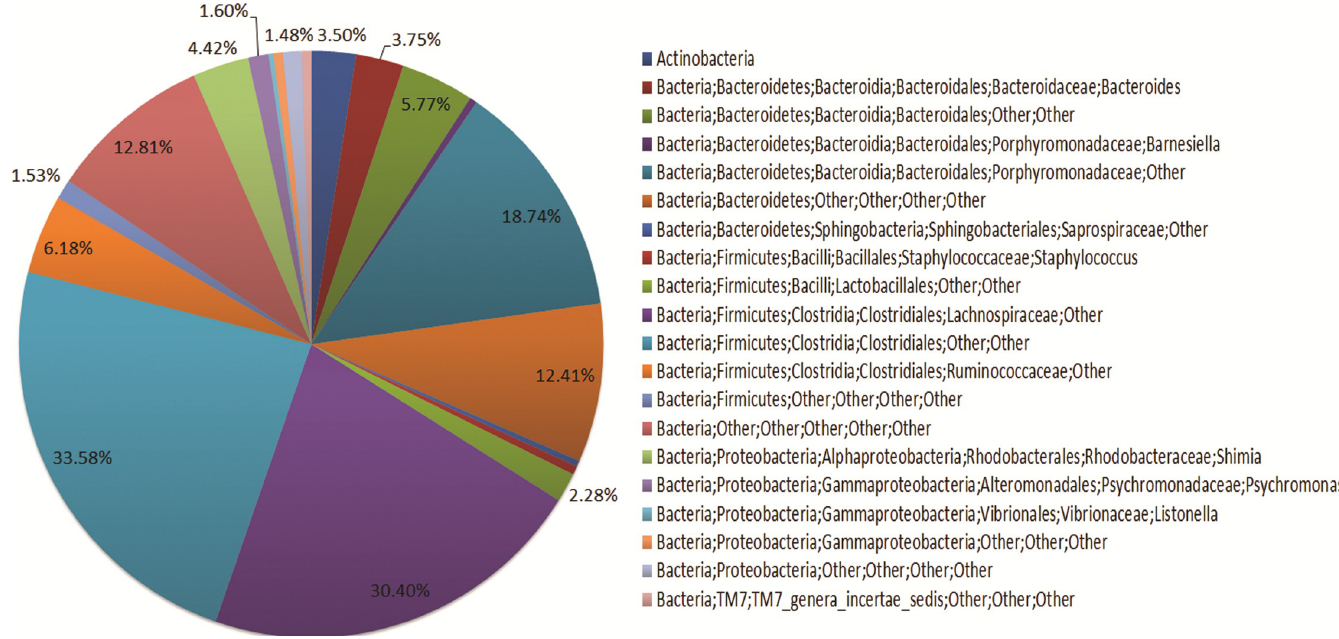
Fig 5. Proposed endogenous bacterial community of H . glaberrima intestine. We propose that the microbiota found in the posterior intestine of the sea cucumber, either in their natural habitat (ocean) or aquarium environments represents the endogenous microbiota of these animals.